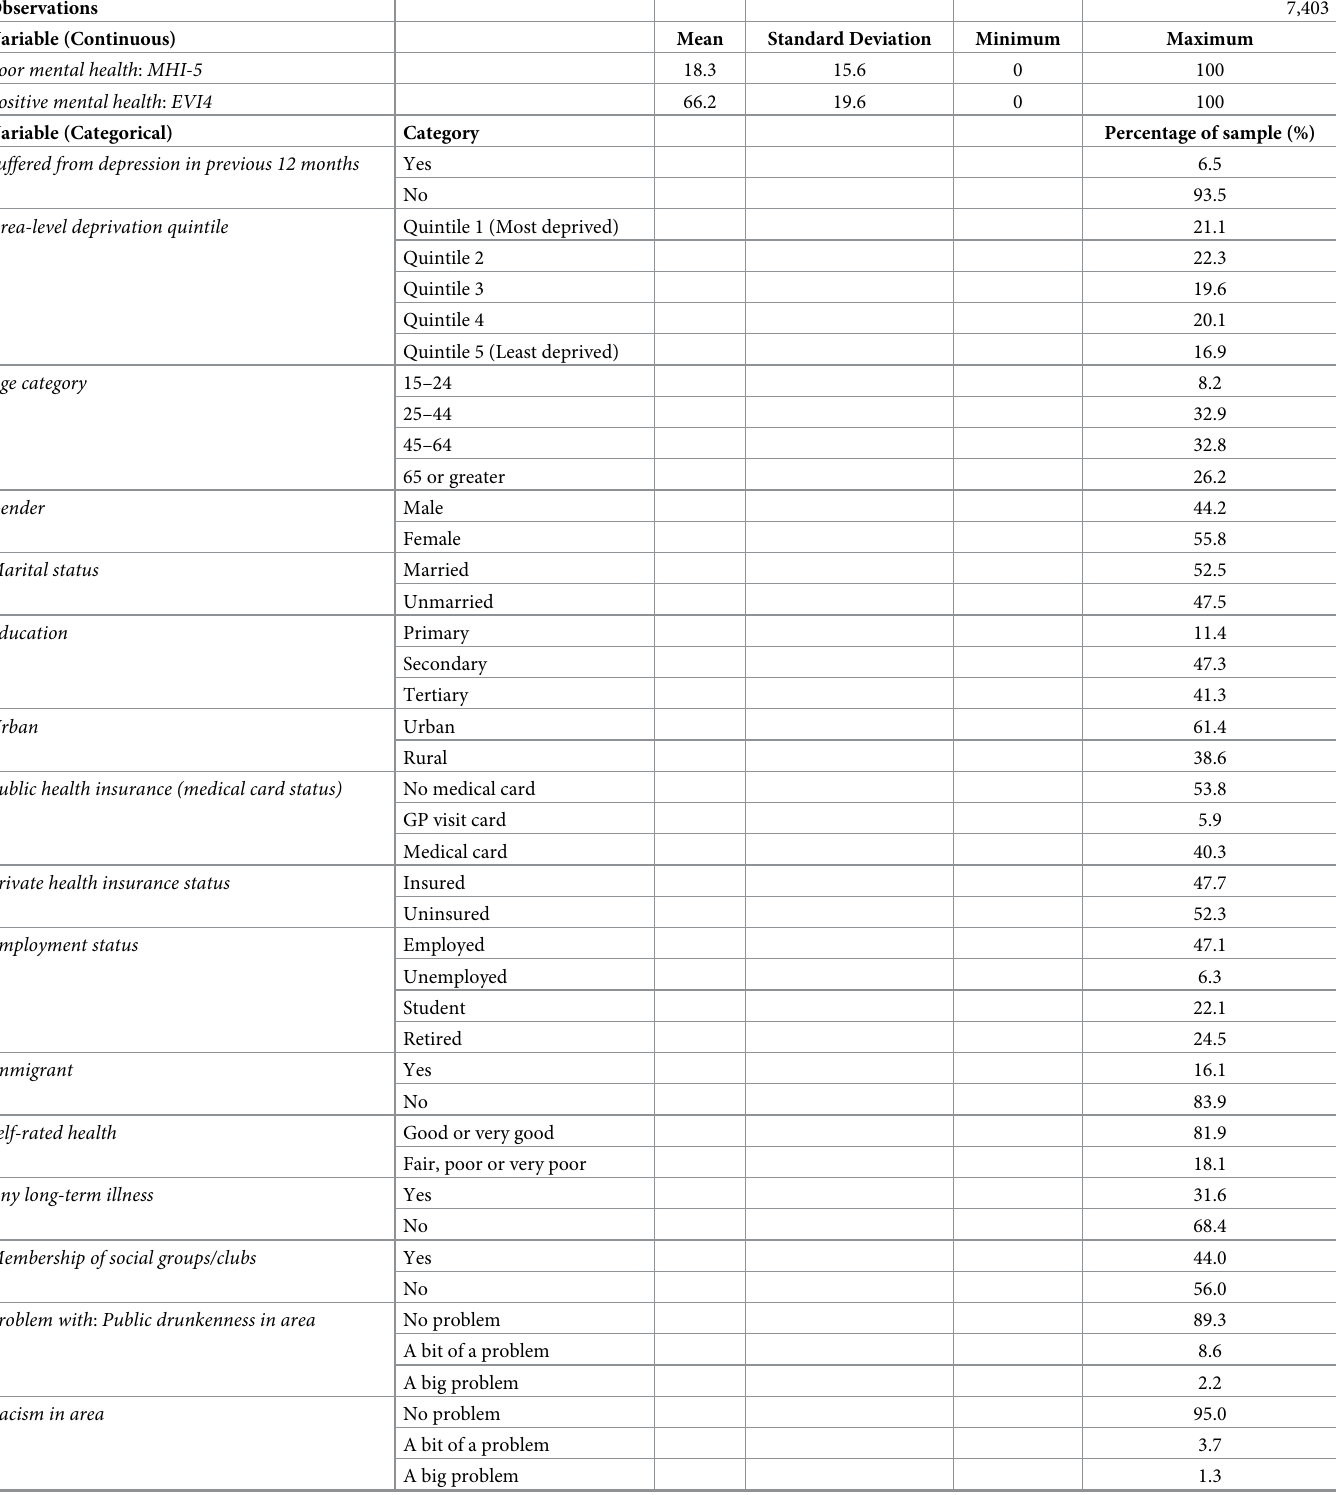
Table 4. Summary statistics, sample for